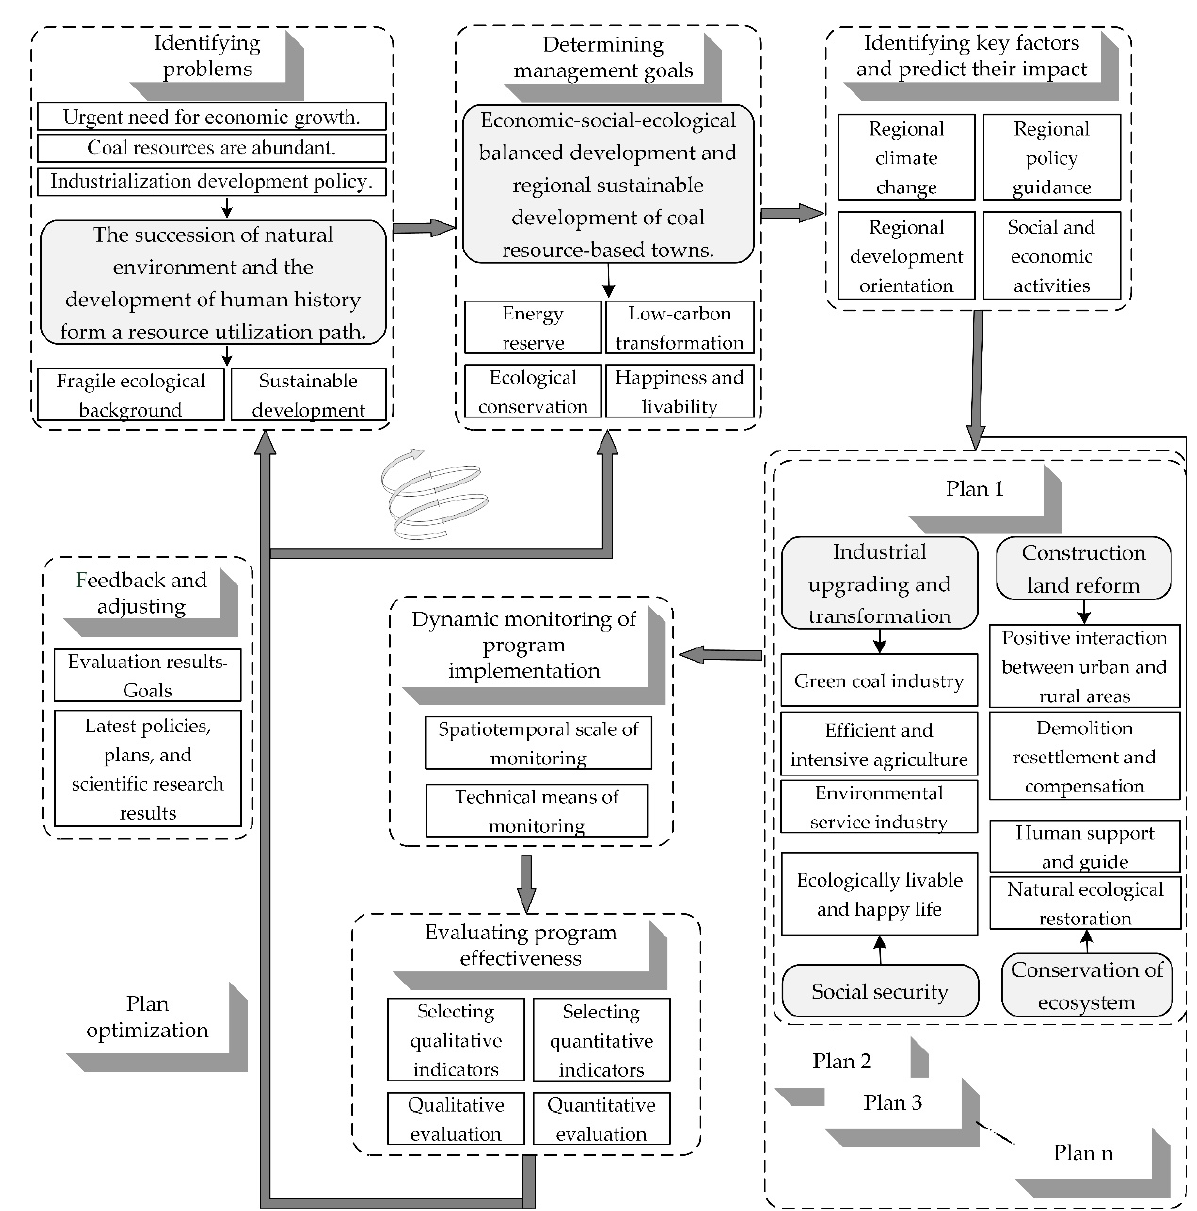
Figure 8. The framework of adaptive management of the social–ecological system of the mine–agriculture–urban compound area of Pinglu. (The logical framework of this figure refers to the research results of Wang et al. in 2007, Engle in 2011, Xia et al. in 2015, and Ma et al. in 2020. The content of this figure summarizes the text content in the above manuscripts, and the figure was made by Shufei Wang.)